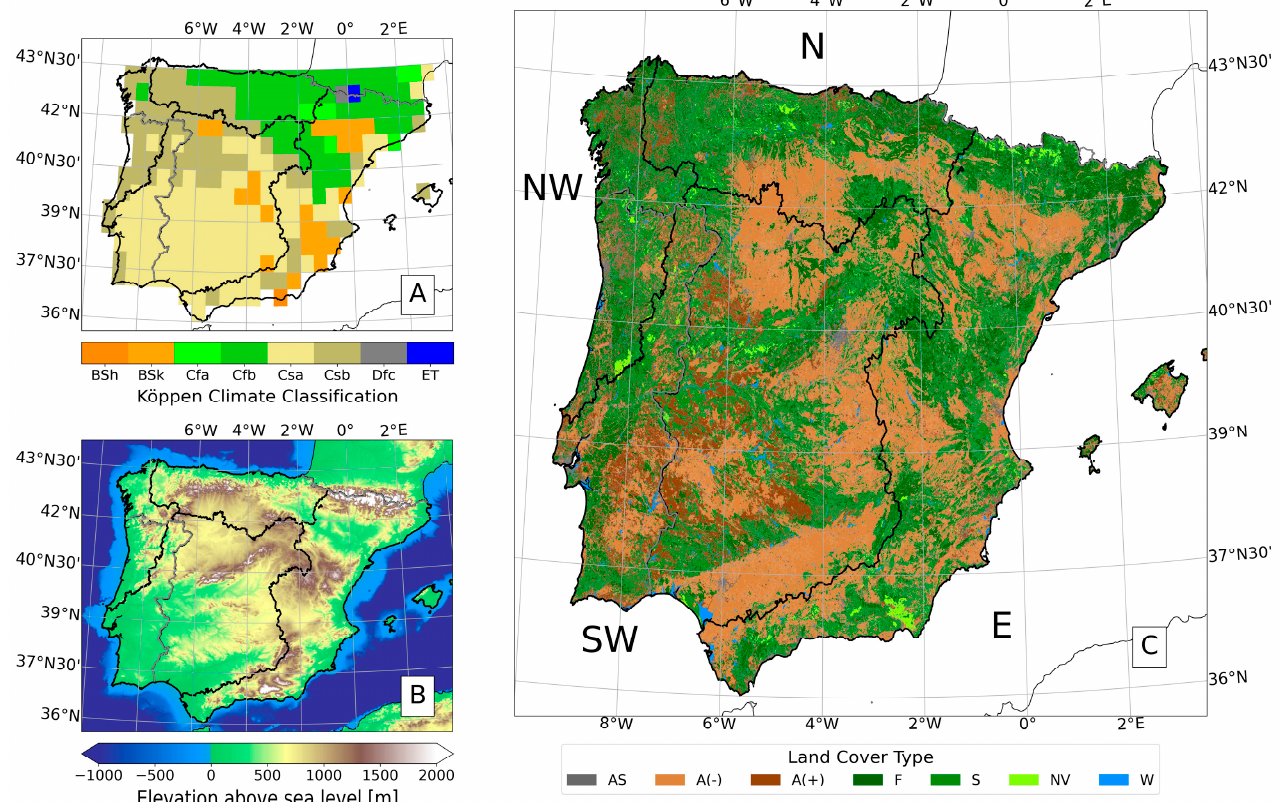
Figure 1. Detailed views of the study region including ( A ) Köppen climate types, as follows: BSh—hot semi-arid, BSk—cold semi-arid, Cfa—humid subtropical, Cfb—temperate oceanic, Csa—hot summer Mediterranean, Csb—warm summer Mediterranean, Dfc—subarctic, Et—tundra; ( B ) topography; and ( C ) land cover types, labeled as follows: AS—artificial surfaces, A( − )—agricultural (less forested), A(+)—agricultural (more forested), F—forest, S—shrub, NV—no vegetation, W—water. In each subplot, the clusters are drawn (in black) as well as the borders (in grey) of Portugal and Spain. The study region comprised the Iberian Peninsula and is shown in Figure 1, where the Köppen climate types (Figure 1A), topography (Figure 1B), and land cover types (Figure 1C) are also detailed. The Köppen climate types (Figure 1A) for the IP were retrieved from Chen and Chen [34], showing that the IP mainly presents mild, temperate, and dry climate types with dry summers, while the northeastern area is humid all year long. The topography of the study region (Figure 1B) was retrieved from Smith and Sandwell [35], with most of southwestern Iberia being flat and presenting low values of altitude, whereas central, eastern, north, and northeastern Iberia includes large mountain ranges, peaking at nearly 3500 m, with most areas being below 1000 m. Land cover types were retrieved from the Copernicus Land Monitoring Service, CORINE Land Cover (CLC) 2018 [36], derived from satellite imagery obtained at different times during 2017 (e.g., forest types were